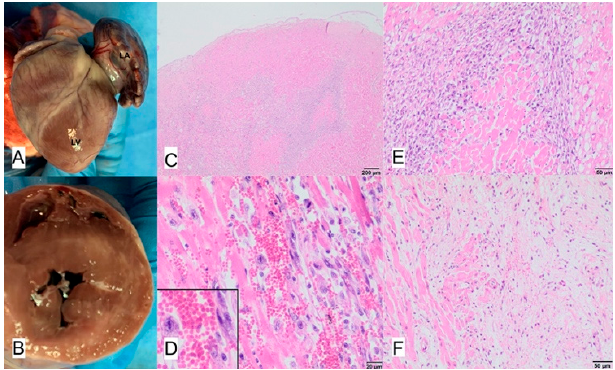
Figure 14. ( A ) Massive enlargement of left atrium, LA—left atrium, LV—left ventricle. ( B ) Thickening of myocardium of left ventricle with numerous pale areas. ( C ) Histopathologic view of myocardium and base of the mitral valve, ( D ) consisting of mononuclear cells, mainly macrophages. ( E ) inflammatory infiltrate producing coalescing nests and bands surrounding cardiomyocytes. ( F ) Macrophages resembling Anitschkow cells (inlet), penetrating the base of mitral valve (border between myocardium, on the left; base of mitral valve, on the right); hematoxylin-eosin stain, magnification bar on particular figures.